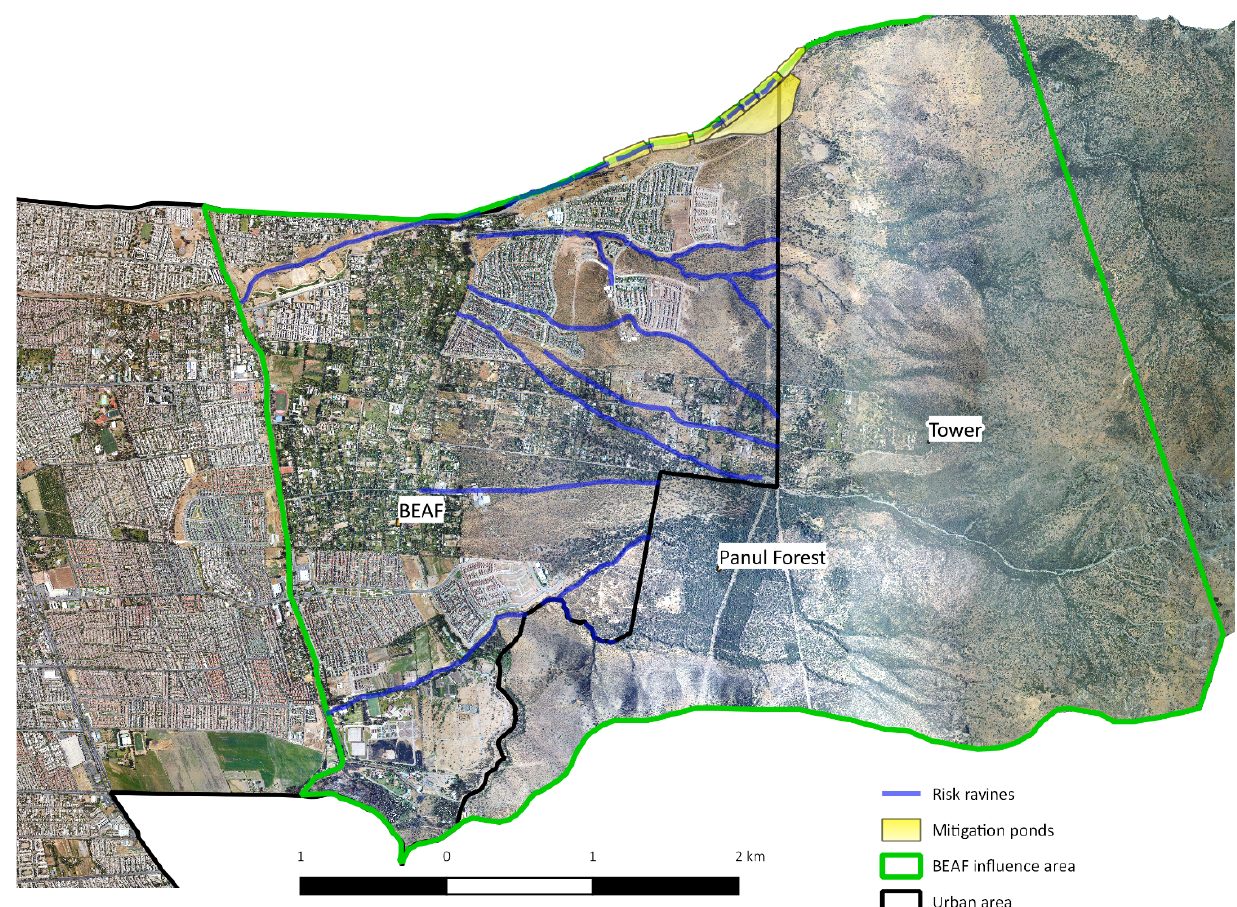
Figure 4. Map with BEAF-related places in the foothills of La Florida. Source: Authors based on interviews and IDE.cl. There, she refers to a new project that emerged from the BEAF, as given the lack of risk-awareness initiatives in the foothills, they designed and constructed a watch- tower in a higher zone of The Andes (Figure 5). Funded mainly through local donations and implemented to- gether with CONAF who provided the lookout workers, the watchtower is five-metres high and has a visibility of over 40 kilometres and aims to help with early haz- ard